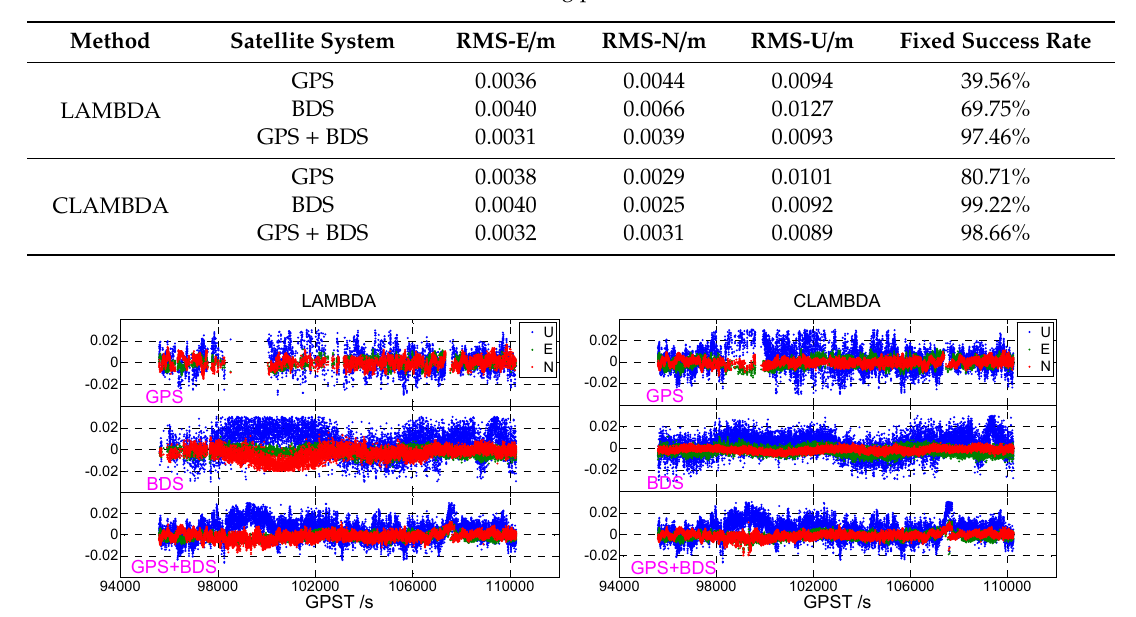
Table 3. Positioning precision statistics.